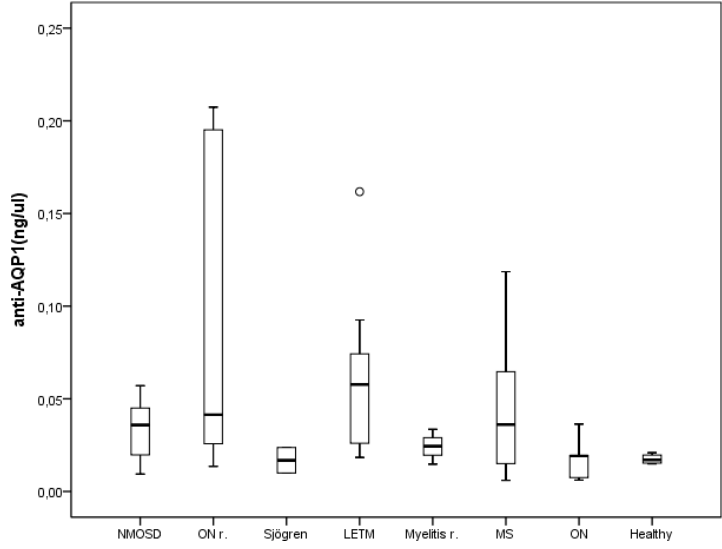
Figure 4. Detection by ELISA assay of anti-AQP1 antibodies in serum of patients. Serums from different pathologies according to the classification shown in Table 1 were analyzed including a group with the NMO spectrum disorder (+NMOSD). Abbreviations of pathologies are as indicated in Table 1. Insignificant differences were obtained among groups by analysis of variance for nonparametric data using the Kruskal–Wallis test ( p = 0.067). Medians and interquartile range are represented and the number of patients analyzed per group were as follows: 8 NMOSD; 6 ON r. (Optic neuritis recurrent); 2 Sjörgen; 9 LETM (Longitudinally extensive transverse myelitis); 3 Myelitis repetition; 18 MS (Multiple sclerosis); 5 ON (Optic neuritis); 4 Control (Healthy). Circle, correspond to an outsider data point.